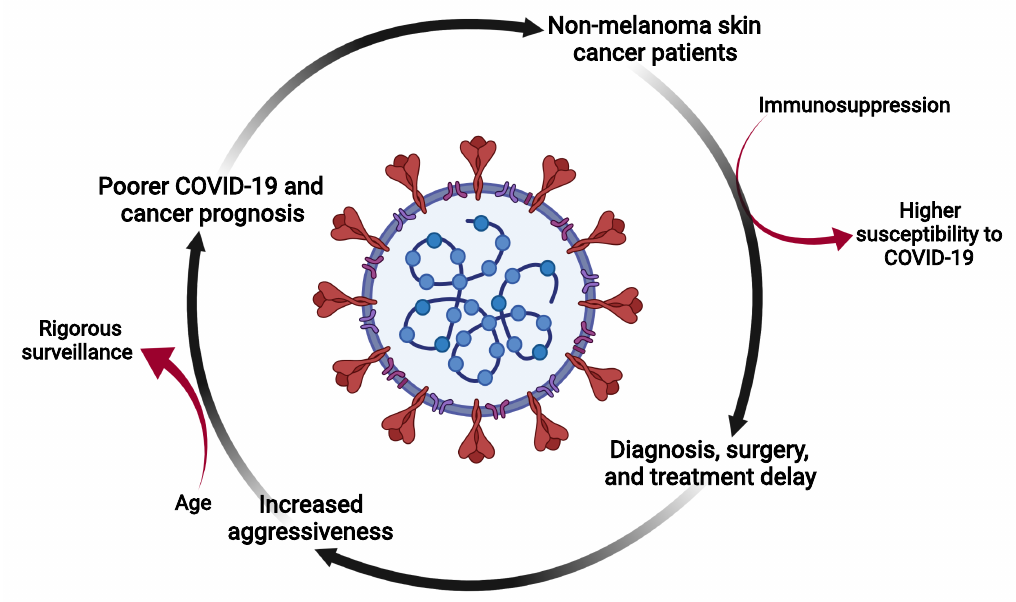
Figure 4. Non-melanoma skin cancer and COVID-19. The COVID-19 pandemic and the related hospital crisis caused health care saturation, and proper attention to patients with special needs was interrupted for more than a year. For patients with NMSC, and even for all types of cancer, a delay in diagnosis and treatments was common. In addition, cancer patients have an increased risk for COVID-19 complications due to immunosuppressive states, mainly caused by debilitating therapies, and the disease itself. This challenging situation may signify an opportunity to develop new strategies to treat patients and overcome current health conditions. The present figure was created with BioRender.com, accessed on 4 May 2022. All icons, templates, and other original artwork appearing in the attached completed graphic are pursuant to BioRender’s Academic License